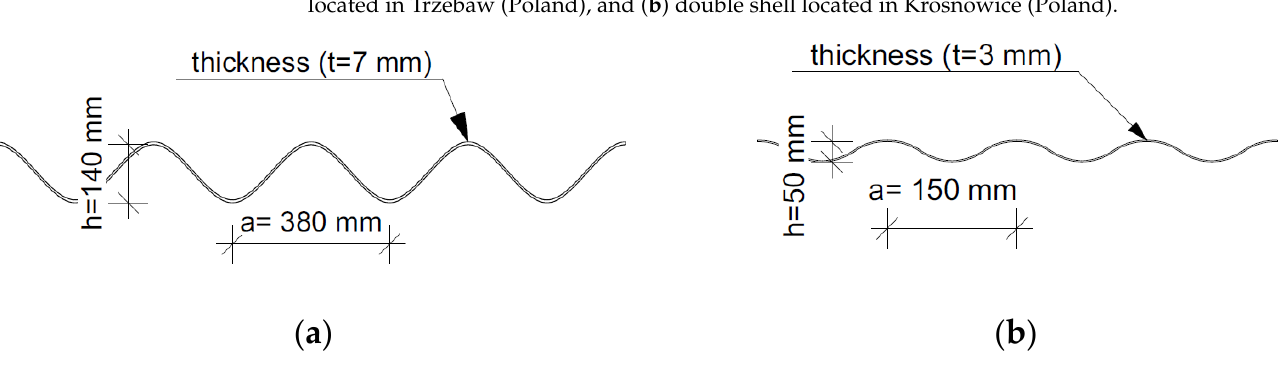
Figure 4. Dimensions of corrugated steel plates of bridge: ( a ) #I and ( b ) #II.